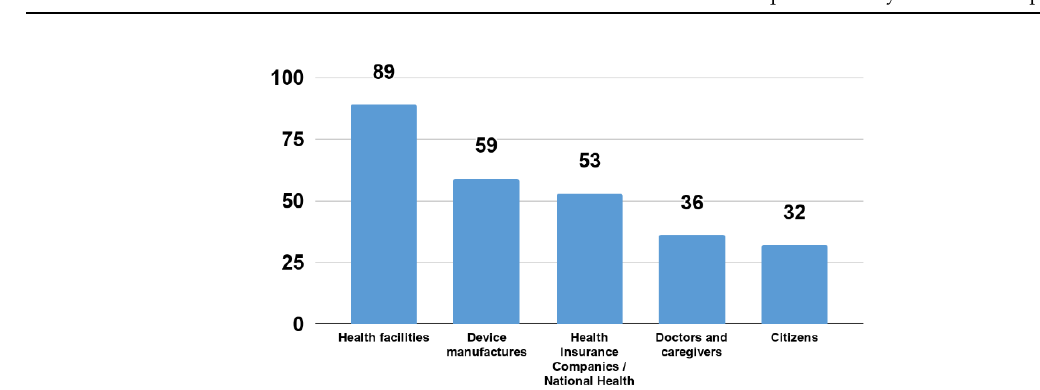
Table 3. Identified stakeholders’ definitions.